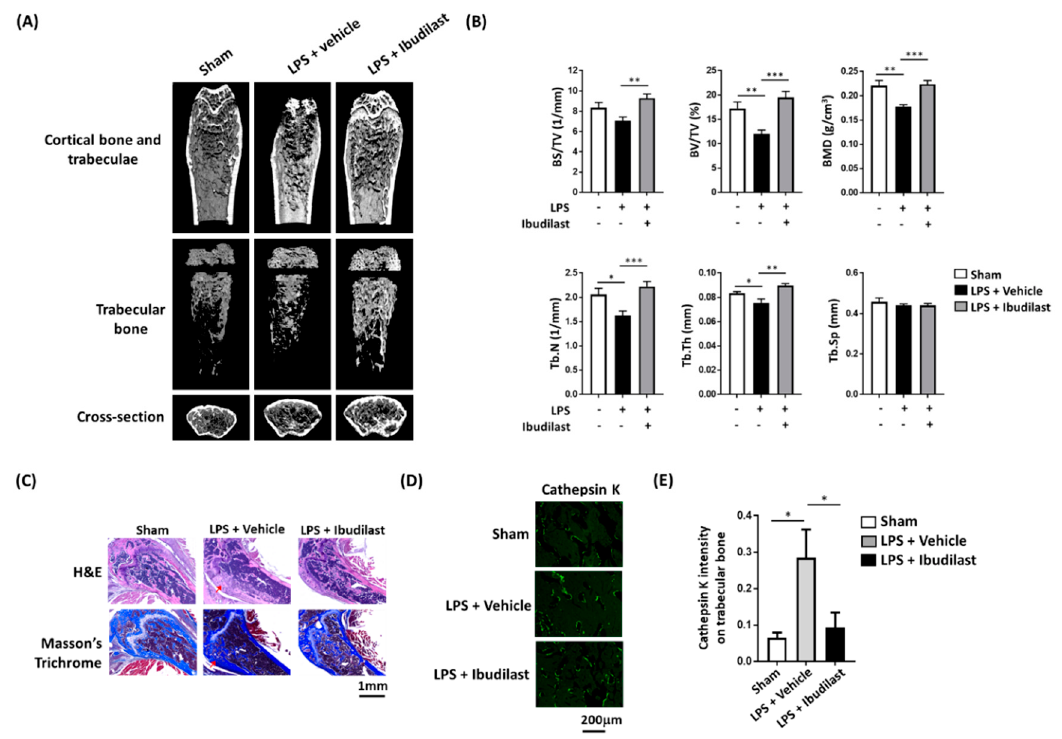
Figure 5. Intraperitoneal administration of ibudilast following intrafemoral injection of LPS protects mice against LPS-induced alteration in bone morphology and prevents osteoclast activation. ( A ) At one hour after intrafemoral LPS injection, mice received intraperitoneal ibudilast or PBS (vehicle) once daily for 3 consecutive days. Micro-CT images revealed that ibudilast exerts protective effects against LPS-induced reduction of bone density. ( B ) Quantitative data analysis confirmed these findings. ( C ) Hematoxylin/eosin and Masson’s trichrome staining revealed a dense bone morphology in PBS-treated mice, whereas LPS injection resulted in bone loosening (black arrow)—a finding which was attenuated by ibudilast administration. ( D ) Immunofluorescence was used to detect cathepsin K (an osteoclast marker). LPS increased cathepsin K fluorescence intensity—a finding which was attenuated by ibudilast administration. ( E ) Quantitative data analysis confirmed these findings. Data are presented as means ± standard errors of the mean. Analyses were conducted with two-way ANOVA followed by Tukey’s post-hoc test. * p < 0.05 , ** p < 0.01, *** p < 0.001. LPS, lipopolysaccharide; PBS, phosphate-buffered saline.